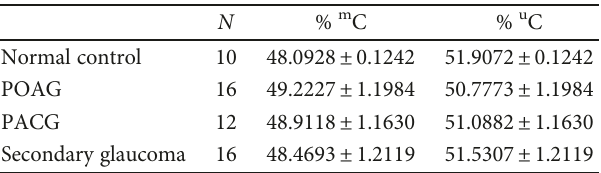
Table 5: HERV-K methylation levels in glaucoma eyes and control eyes. N % m